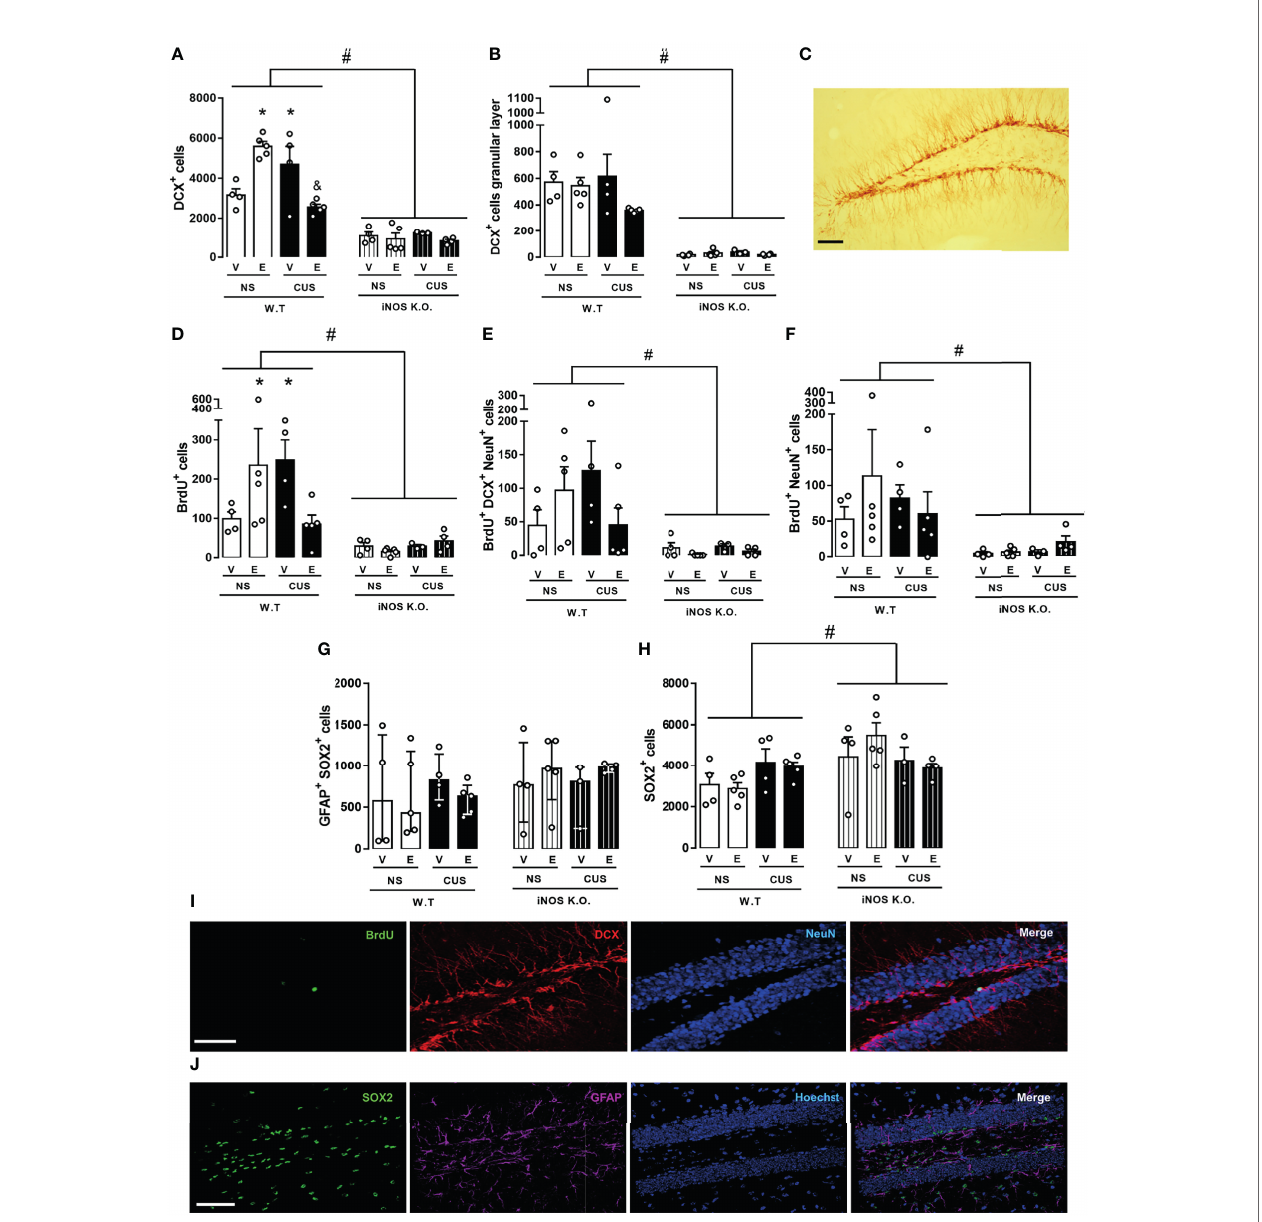
FIGURE 5 | Escitalopram does not modify the AHN impairment observed on iNOS K.O. mice. Quanti fi cation of neuroblast total number and migration towards the granular layer [ (A, B) , respectively]. BrdU incorporation analysis revealed a reduced survival of adult-born new neurons on iNOS KO mice that was not affected by escitalopram or CUS interventions [ (D – F) ; n=4,5,4,5,4,5,3 and 4, respectively]. Type I cells analysis showed that these cells are not altered on iNOS KO mice, nor was affected by any manipulations employed (G) . Quanti fi cation of SOX2 positive cells [ (H) ; n=4,5,4,5,4,5,3 and 4, respectively]. Representative image showing DCX, BrdU/DCX/NeuN and GFAP/SOX2 positive cells in the dentate gyrus of a WT non-stressed animal [ (C, I, J) , respectively; scale bar = 50 µm]. Data present as mean ± SEM (A, B, D – F, H) or median and interquartile range (G) * indicates p<0.05 compared to WT NS mice. # indicates p < 0.05 on genotype factor, & p < 0.05 compared with WT CUS vehicle